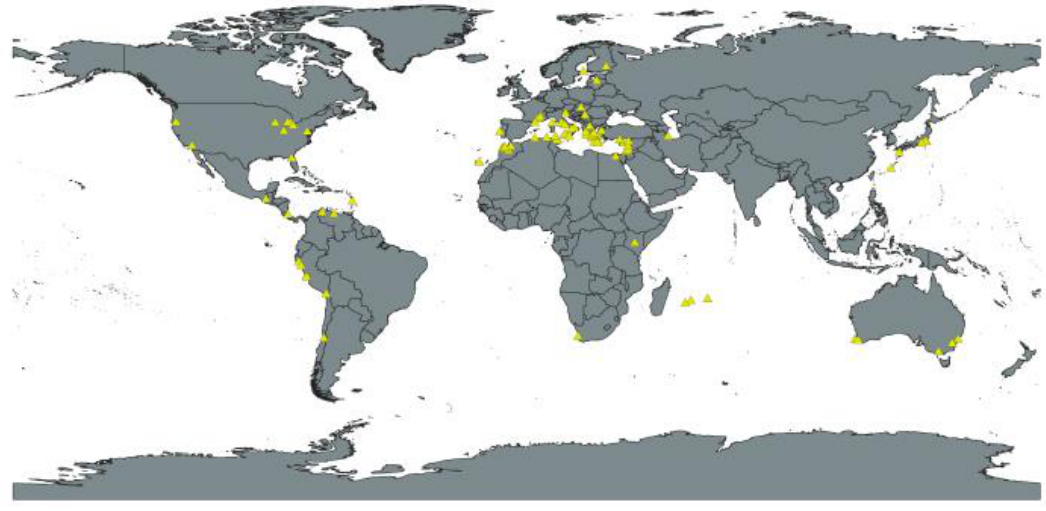
Figure 1. Global occurrence of Phytoseiulus persimilis . The triangles represent the distributions.